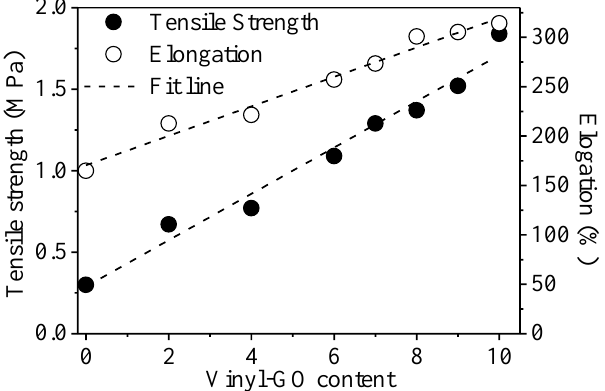
Figure 4. The tensile properties of SR/vinyl-GO nanocomposites.